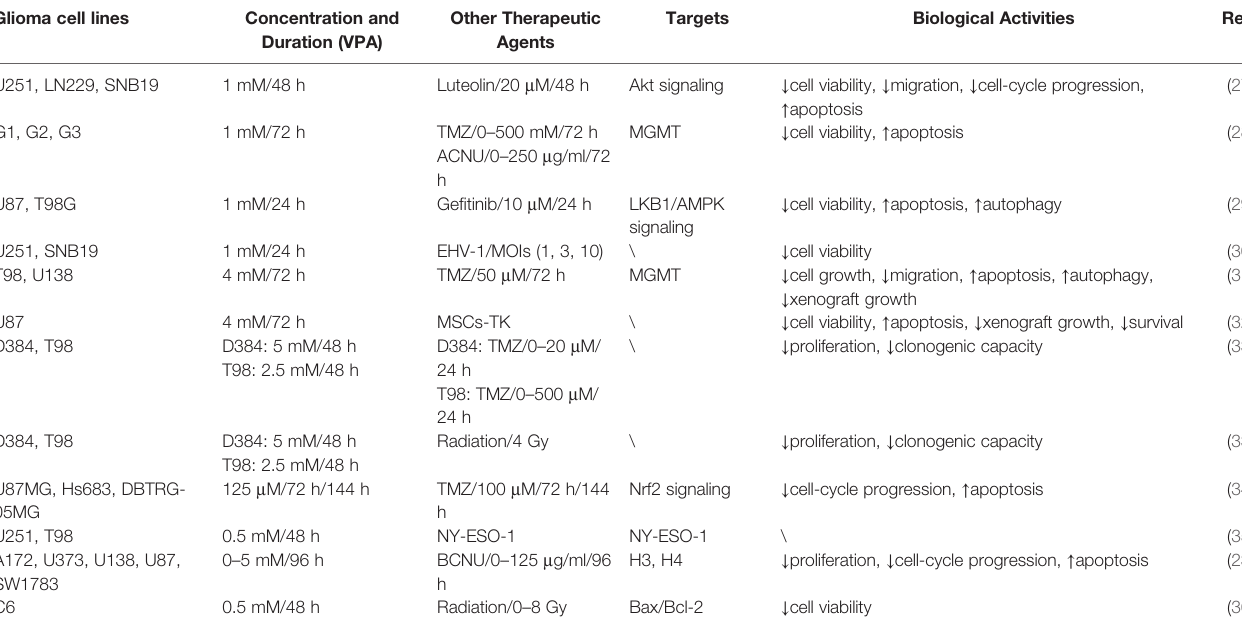
TABLE 2 | VPA served as an adjuvant agent in glioma treatment via involvement with cellular activities and biological targets. Glioma cell lines Concentration and Other Therapeutic Duration (VPA) Agents